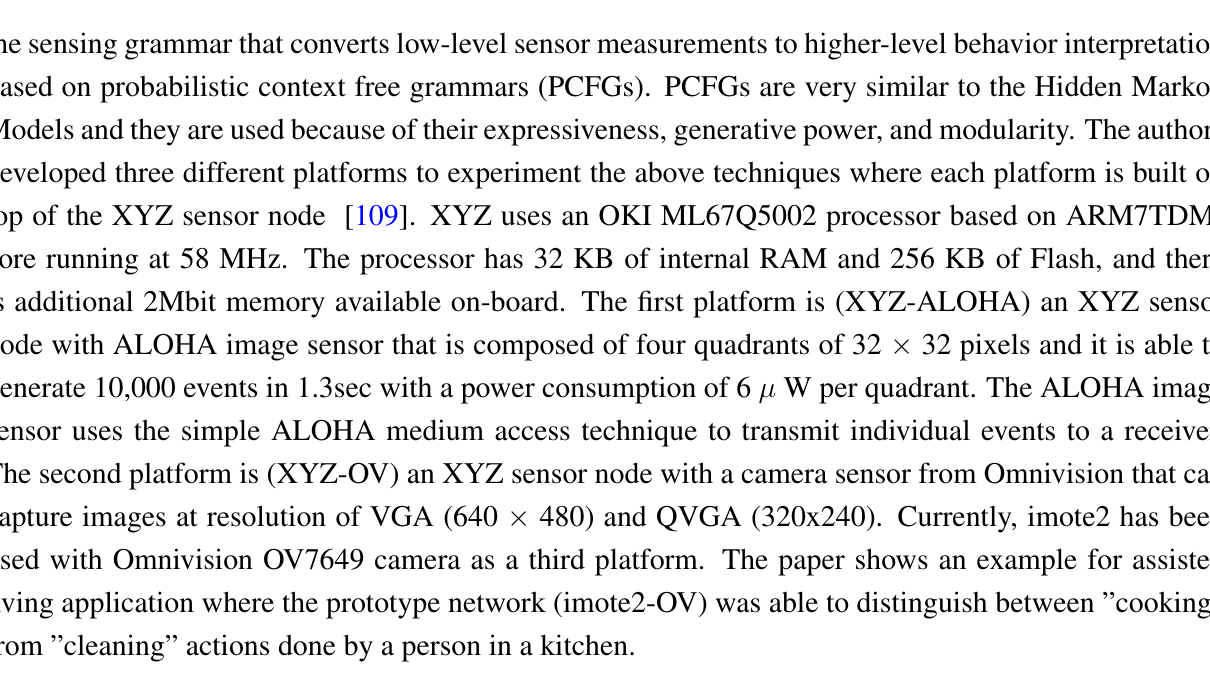
Table 5. WMSN Camera Motes Features and